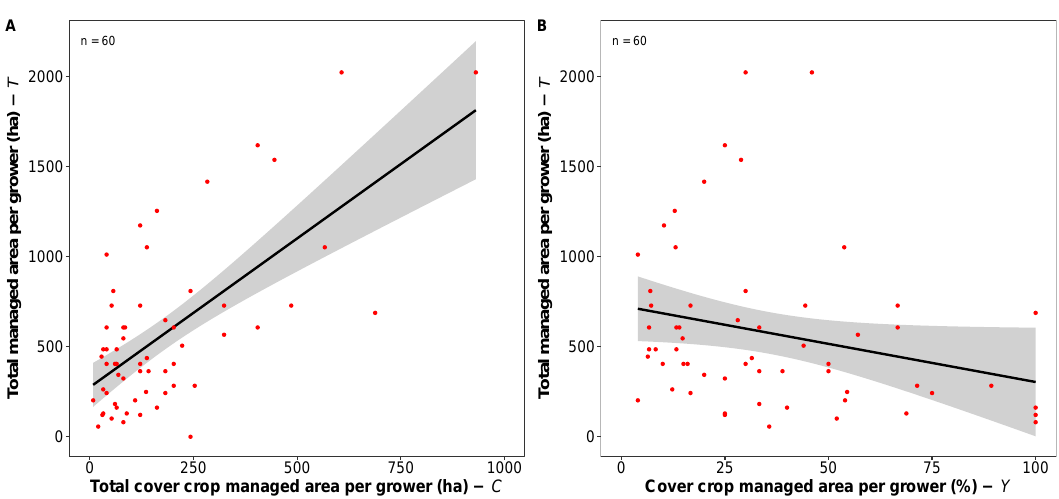
Figure 3. Correlation between per grower total ha managed and ( A ) the total ha planted to cover crops and ( B ) the % ha planted to cover crops. In ( A ), the correlation is 0.66 (lower confidence interval [CI] 0.49–upper CI 0.78) with p -value= 0.00. In ( B ), the correlation is − 0.25 (lower CI − 0.48–upper CI 0.01) with p -value= 0.05. The black line represents the linear trend and the shaded area the 95%